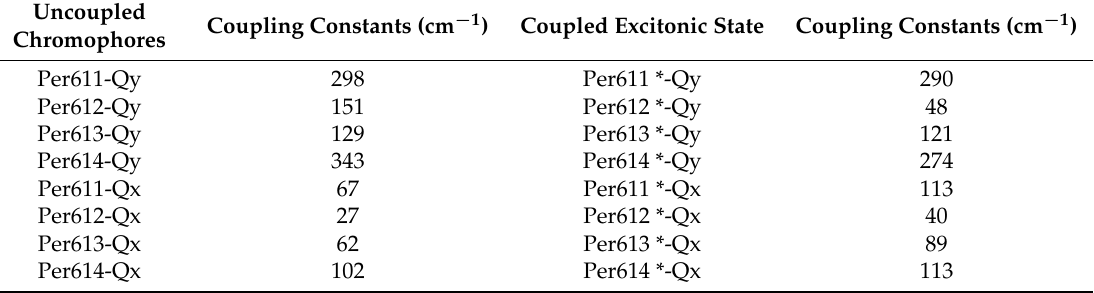
Table 2. Comparison of Per-Chl a interaction strengths for uncoupled and coupled Pers in a domain of